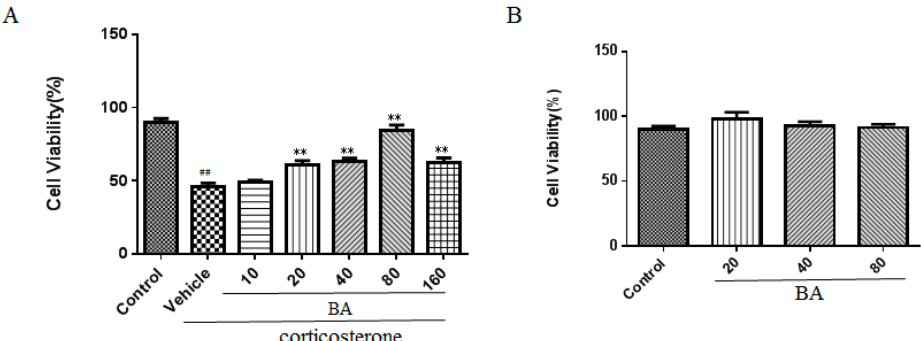
Figure 7. Effects of BA on cell viability in PC12 cells. ( A ) in the presence of corticosterone, ( B ) in the absence of corticosterone. Data were expressed as mean ± SEM ( n = 6). ## p < 0.01 vs. the control; ** p < 0.01 vs. the corticosterone group.